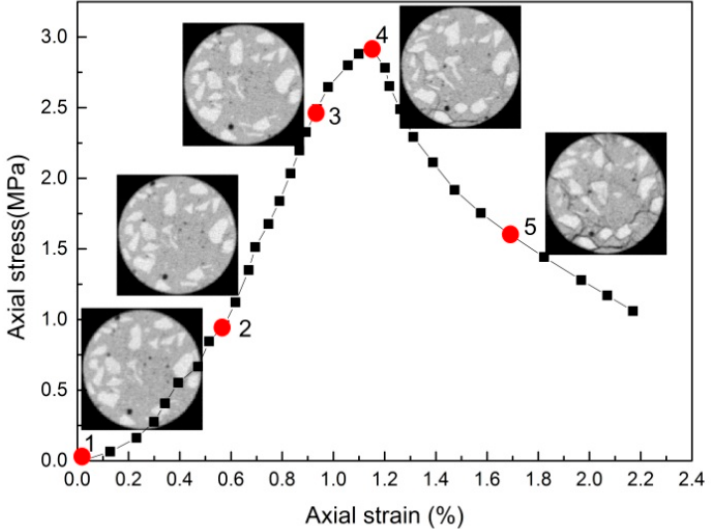
Figure 7. The axial stress strain curve for the CWRB-6 sample. The determination of the CT scanning stages refers to the macroscopic stress strain curve.